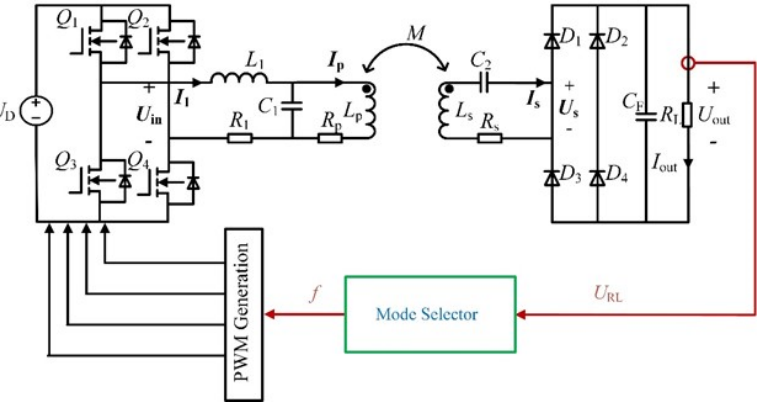
Figure 9. Switching strategy for the proposed LC/S compensated IPT system.